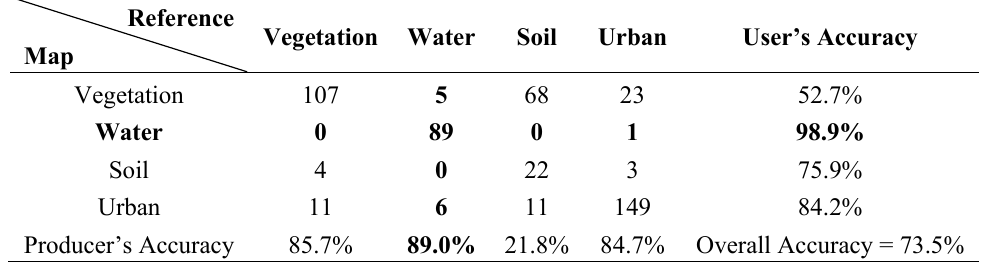
Table 1. Error matrix for before-Katrina classification, Maximum Likelihood classifier.